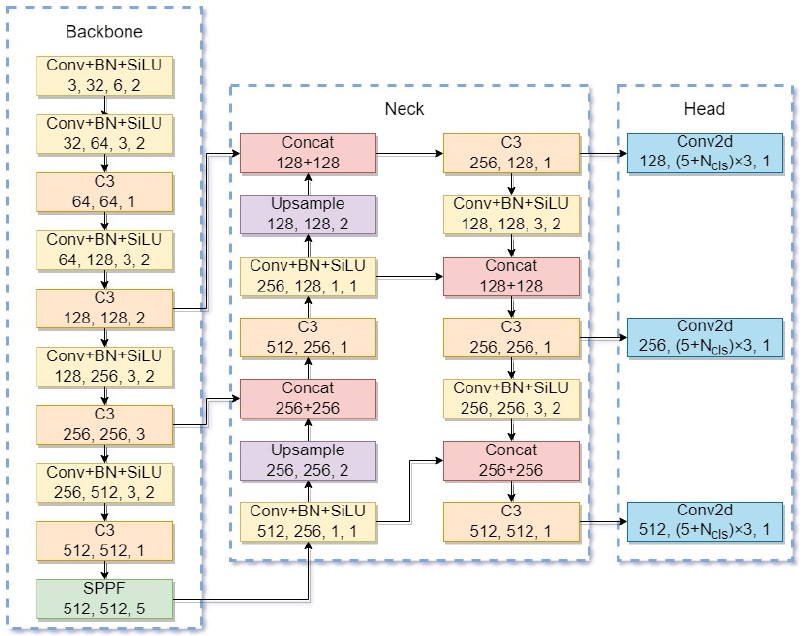
Figure 1. The diagram of YOLOv5s network structure.